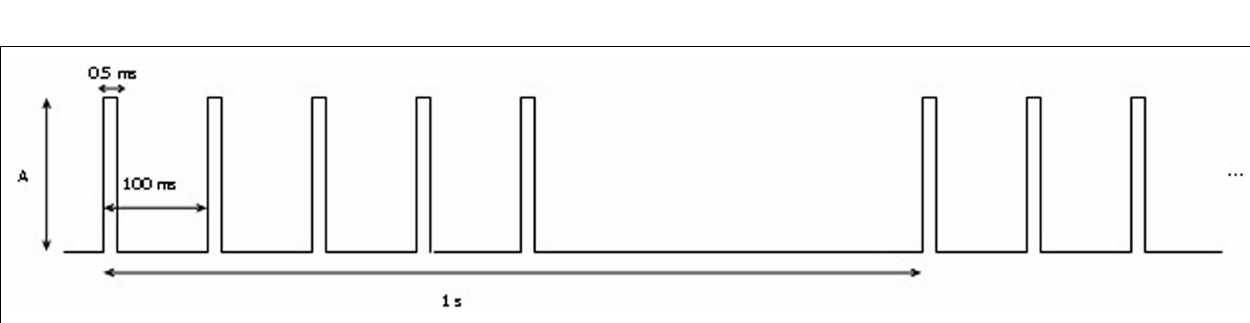
FIGURE 7 | Stimulation protocol:A represents the amplitude of the signal . It was increased from 1 to 3mA by 0.5A per